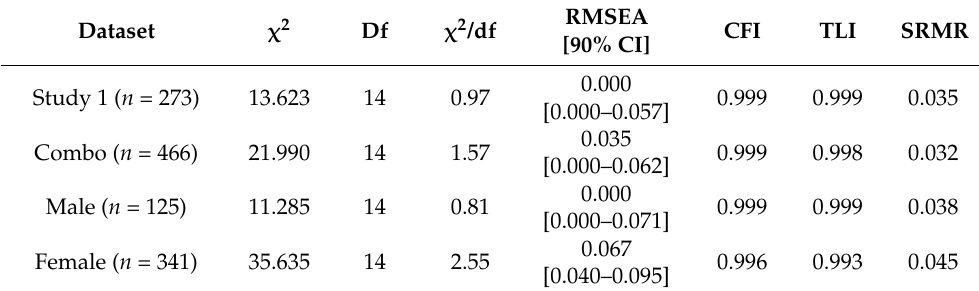
Table 3. Confirmatory factor analysis of newly proposed 7-item SPAS.